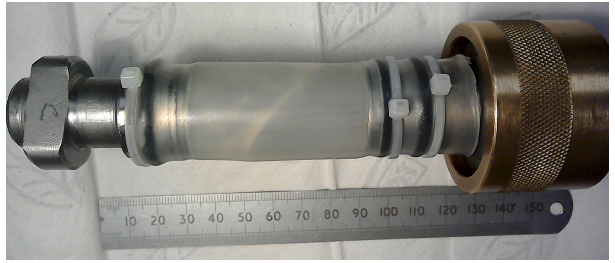
Figure 3. A jacketed sample with a 45 ◦ pre-cut. Around the sam- ple is a 3mm (wall thickness) soft silicone rubber sleeve to min- imize the risk of the sliding parts puncturing the outer jacket that seals against ingress of confining pressure fluid. On the left is the bayonet connector that allows samples to be tested in axisymmetric extension as well as in axisymmetric shortening. Scale divisions are